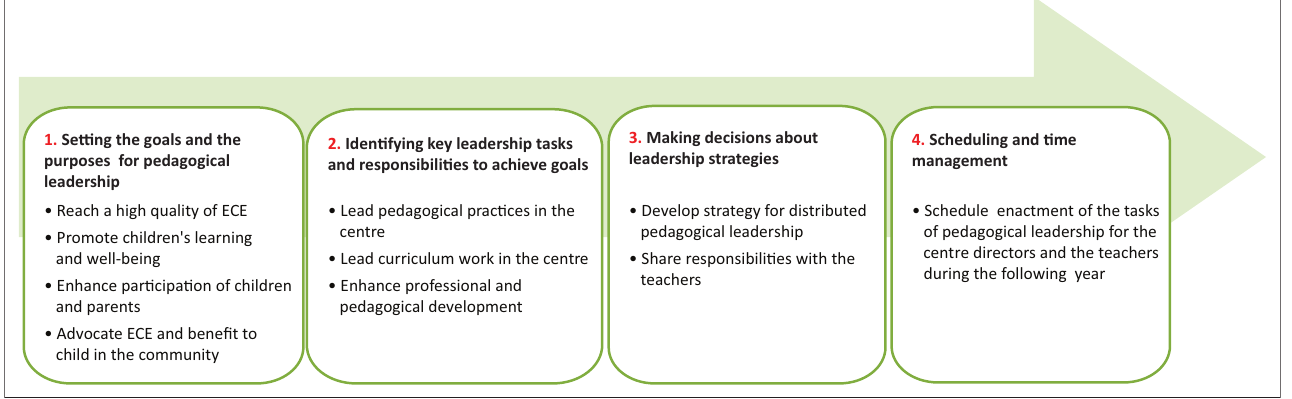
1. Se(cid:31)ng the goals and the purposes for pedagogical